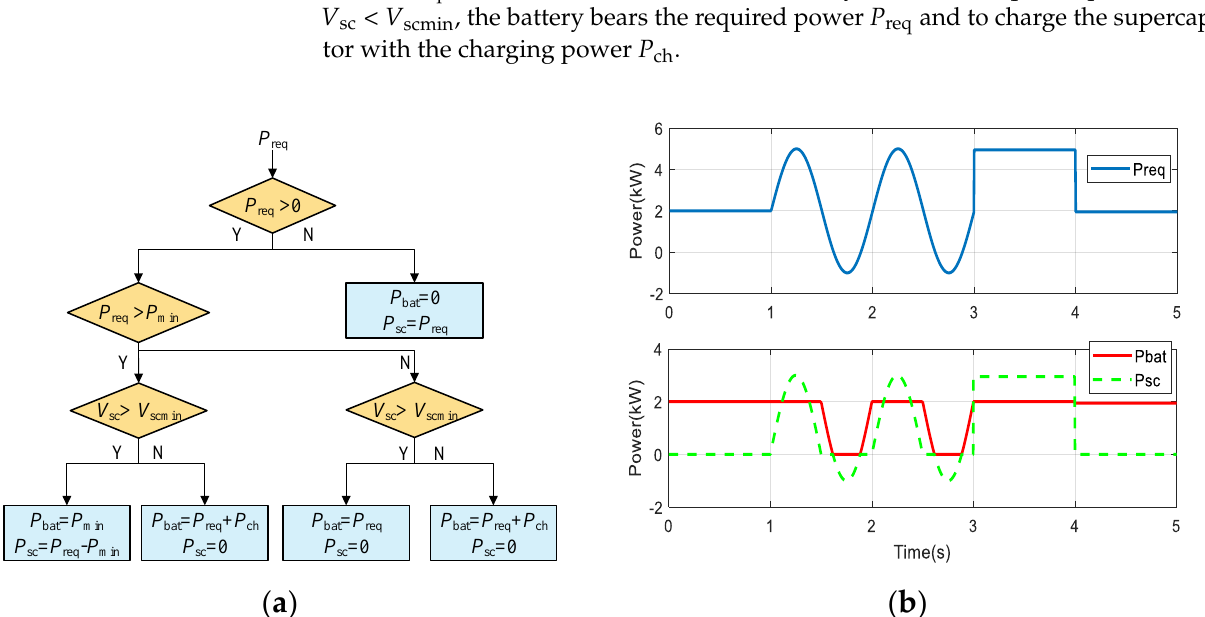
Figure 2. ( a ) The rule − based energy management strategy (EMS); ( b ) the artificial load power and its distributed results.